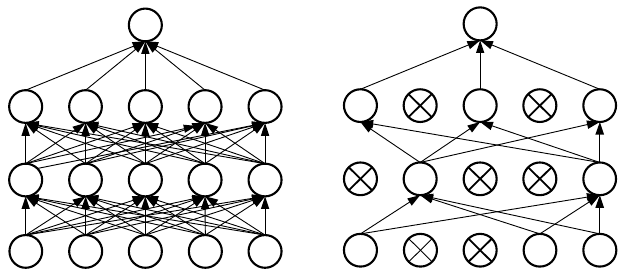
Figure 3. The principle of dropout.